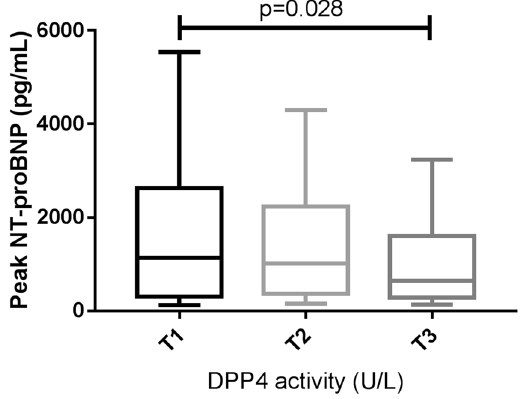
Figure 1. Peak NT-proBNP according to plasma DPP4 activity tertiles in STEMI patients. Values represent as median with interquartile range. Box plots show the 10th and 90th (vertical lines), 25th and 75th (boxes) and 50th (horizontal line).